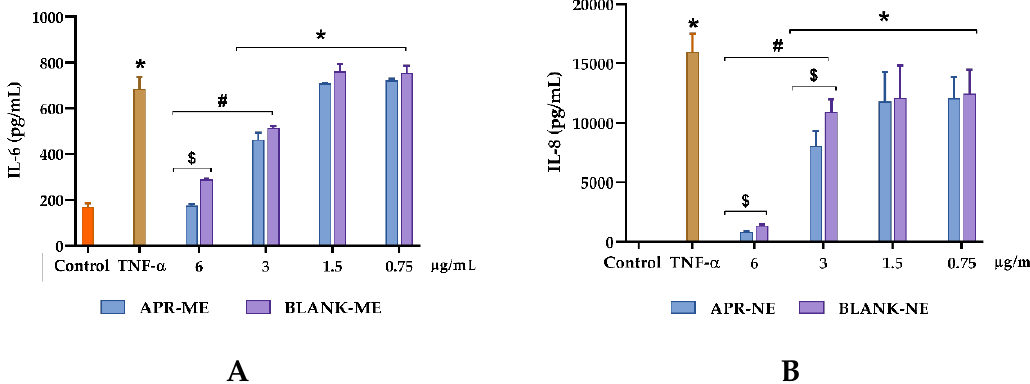
Figure 7. Inhibition of inflammatory response of cytokines in HaCaT cell line. ( A ) Interleukin-6 (IL-6); and ( B ) Interleukin 8 (IL-8). Control − : untreated cells; Control + : positive control. APR-ME: cells treated with apremilast microemulsion; and Blank-ME: cells treated with drug free vehicle. Results are expressed as mean ± SD ( n = 3) Statistically significant difference: *, comparison with negative control; #, comparison between concentrations; and $, comparison between APR-ME and Blank-ME.